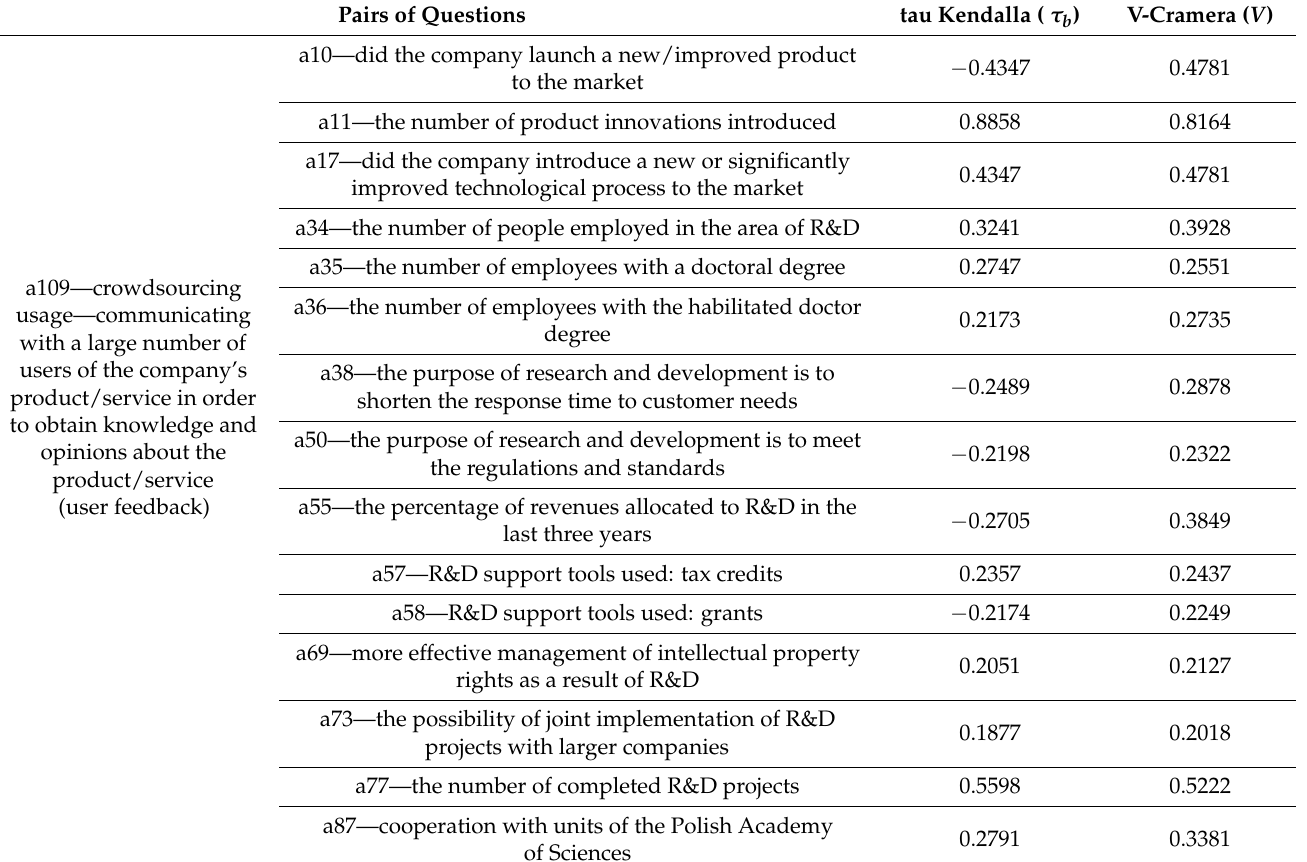
Table 2. The value of the Kendall and V-Cramer tau correlation coefficients. Pairs of